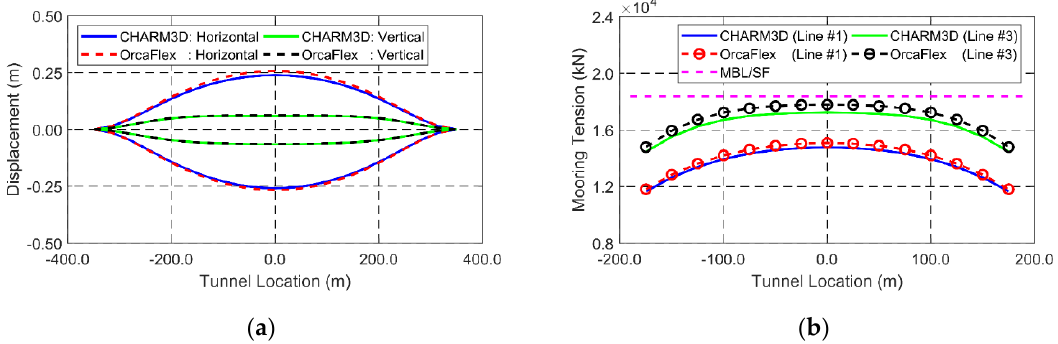
Figure 6. Envelopes of the maximum and minimum displacements of the tunnel ( a ) and mooring tension ( b ) in the 100-year-strom condition.